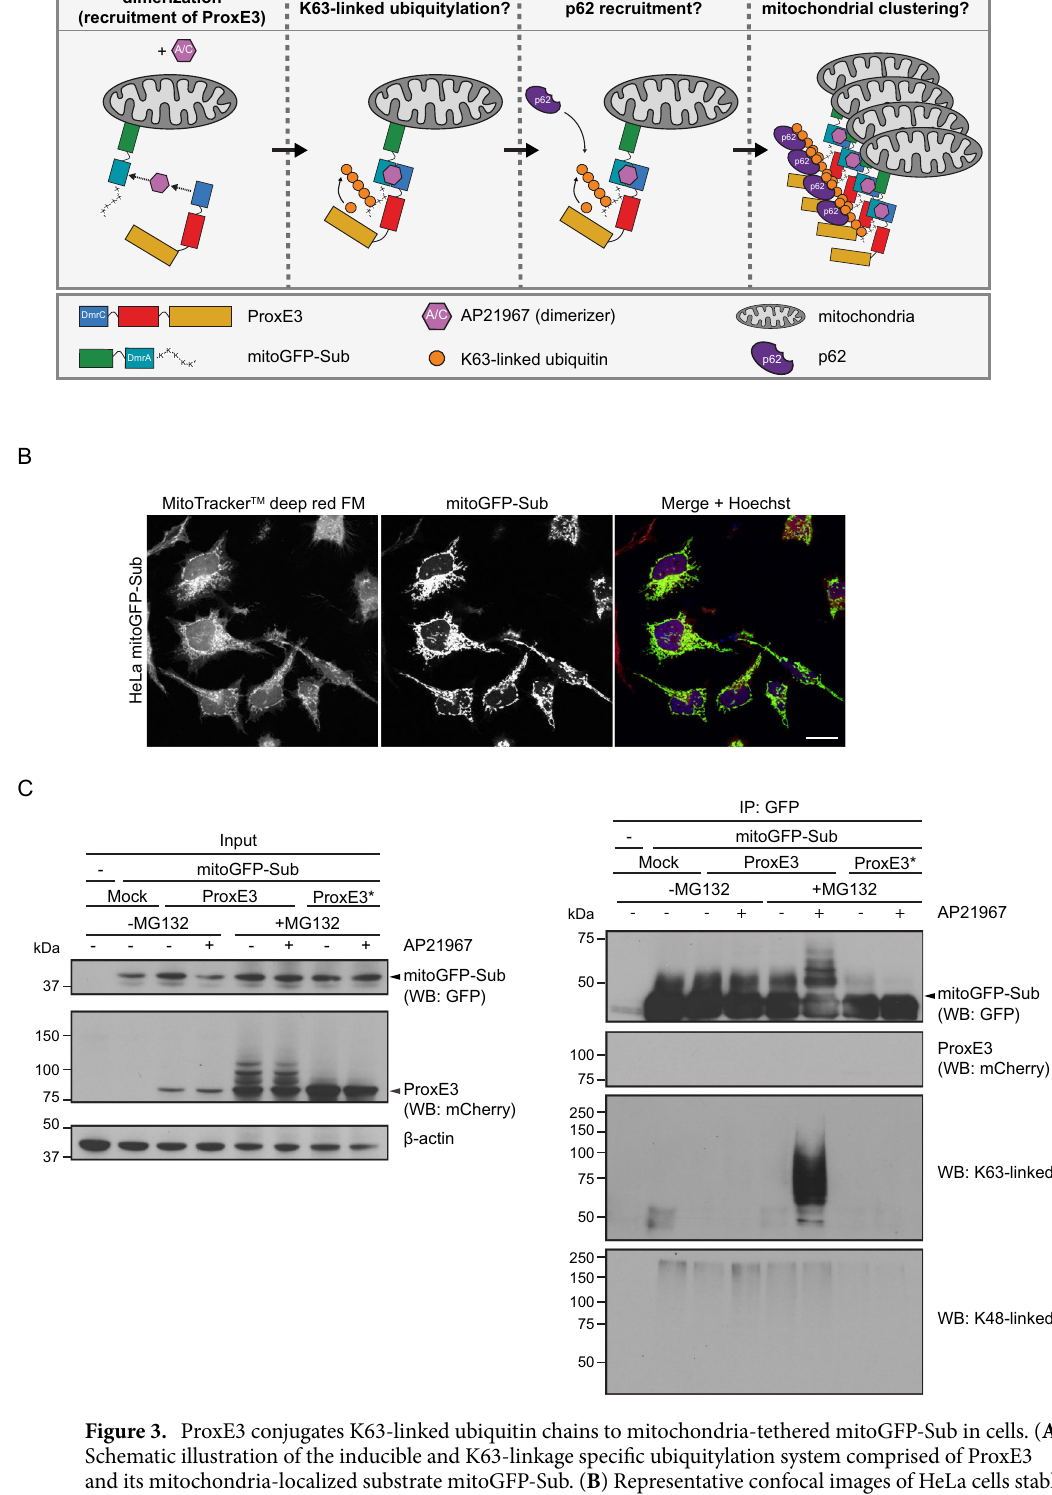
Figure 3. ProxE3 conjugates K63-linked ubiquitin chains to mitochondria-tethered mitoGFP-Sub in cells. ( A ) Schematic illustration of the inducible and K63-linkage specific ubiquitylation system comprised of ProxE3 and its mitochondria-localized substrate mitoGFP-Sub. ( B ) Representative confocal images of HeLa cells stably expressing mitoGFP-Sub. ( C ) Denaturing immunoprecipitation of GFP fusions in parental HeLa cells (−) or HeLa cells stably expressing mitoGFP-Sub (mitoGFP-Sub) and transiently transfected with mCherry-tagged ProxE3, the catalytically inactive ProxE3* or mock transfected and treated for 12 h in the presence or absence of 10 µM MG132 (+ MG132 and − MG132 respectively) and/or 400 nM AP21967. Arrows indicate the unmodified protein of interest (either mitoGFP-Sub or